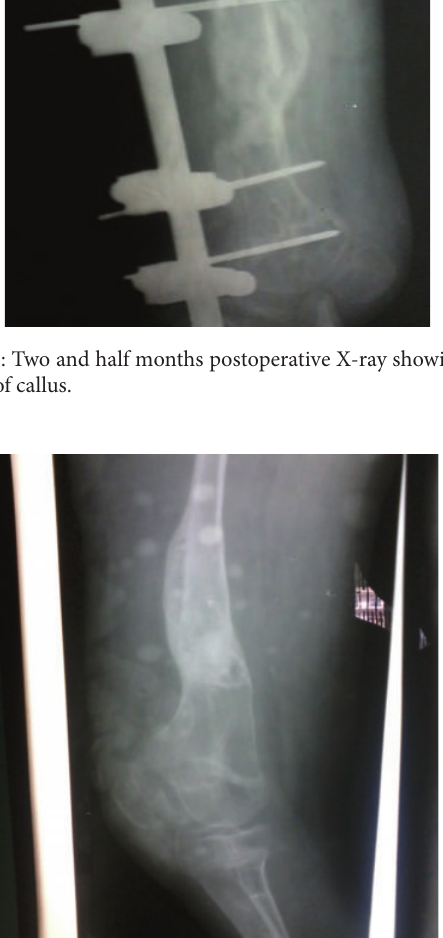
Figure2:PlainX-rayofrightthighanteroposteriorandlateralviews showing fracture of femur at junction of middle and distal third with screws in situ used for hemiepiphysiodesis.